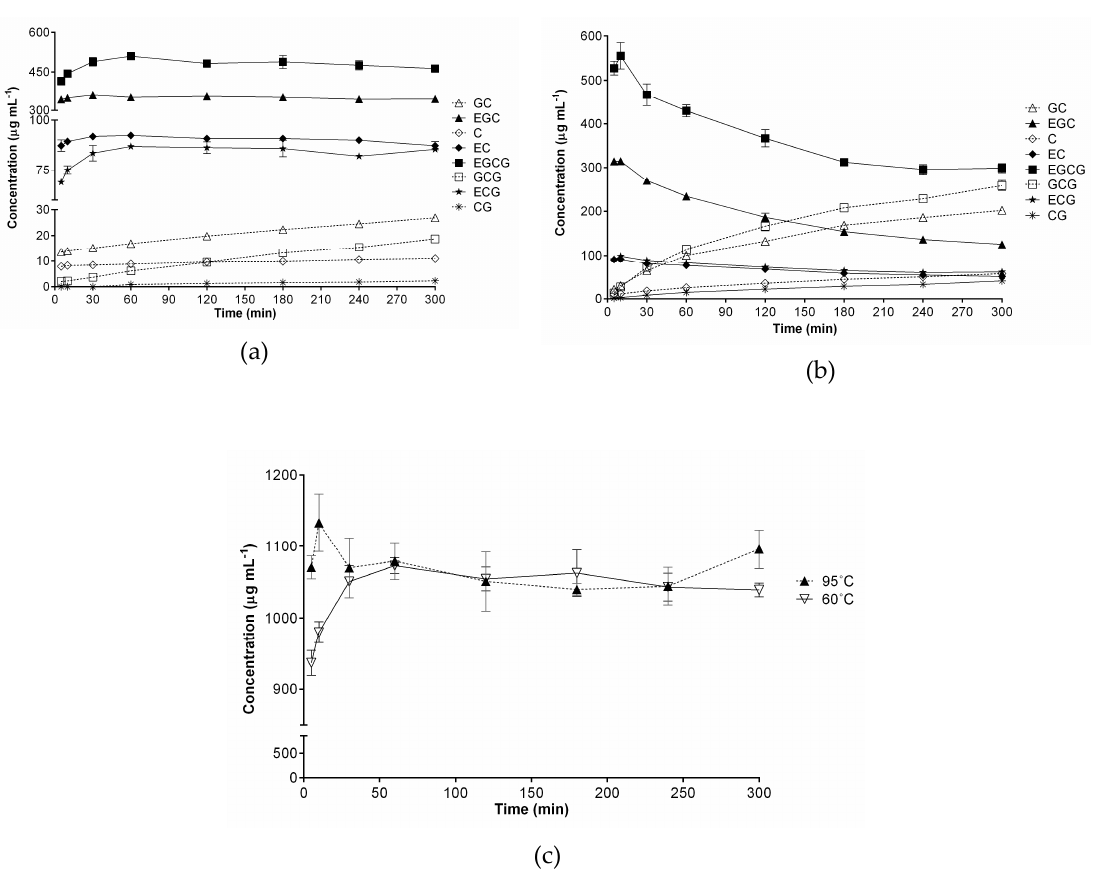
Figure 3. Quantification of eight catechins in green tea infusions brewed at 60 ◦ C ( a ); 95 ◦ C ( b ); and, total catechin concentrations ( c ).